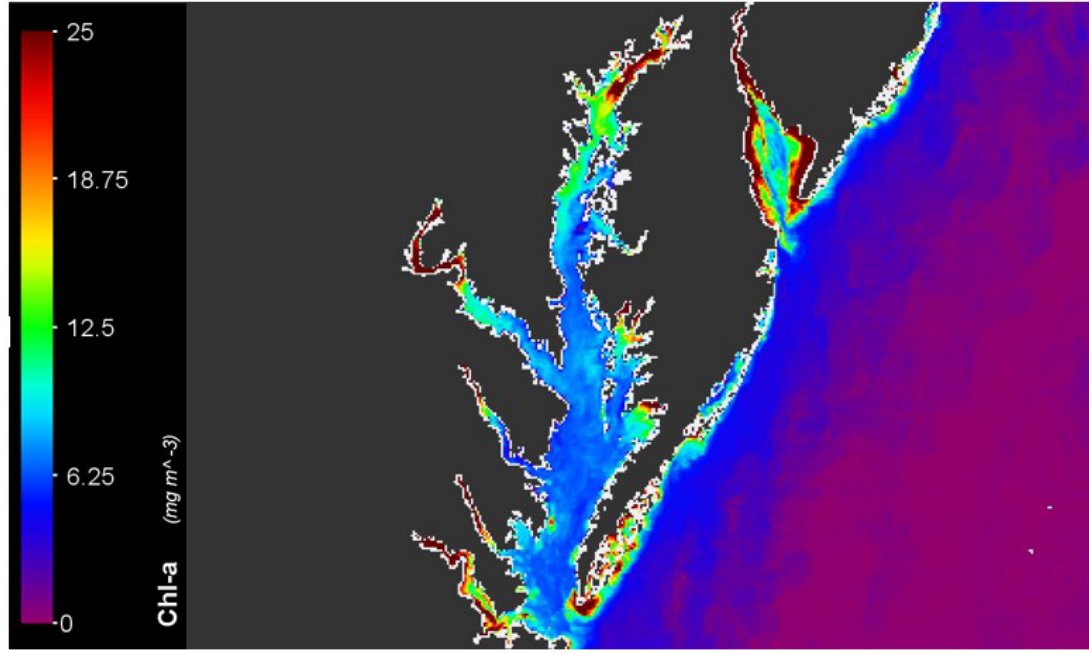
Figure 7. Example of Satellite-estimated Chl-a concentrations for Chesapeake Bay obtained by the GROC4 algorithm on MODIS level-2 image (dated 18 October applying the GROC4 algorithm on MODIS level-2 image (dated 18 October 2017).